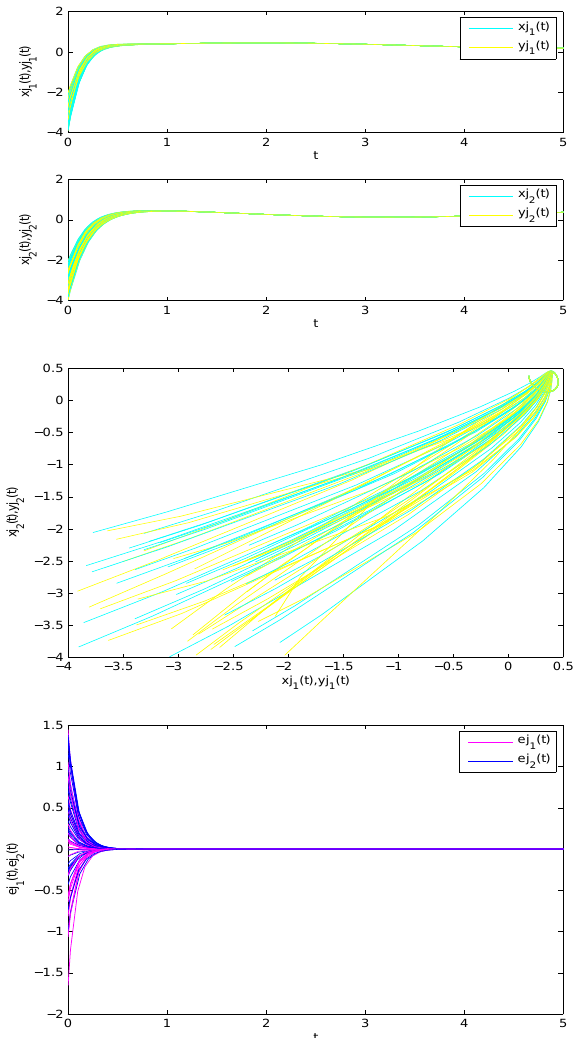
Figure 3. Instantaneous error states for the J part between for the variable ˘ x of (18) and ˘ y of (19) under 30 random initial values for asymptotical